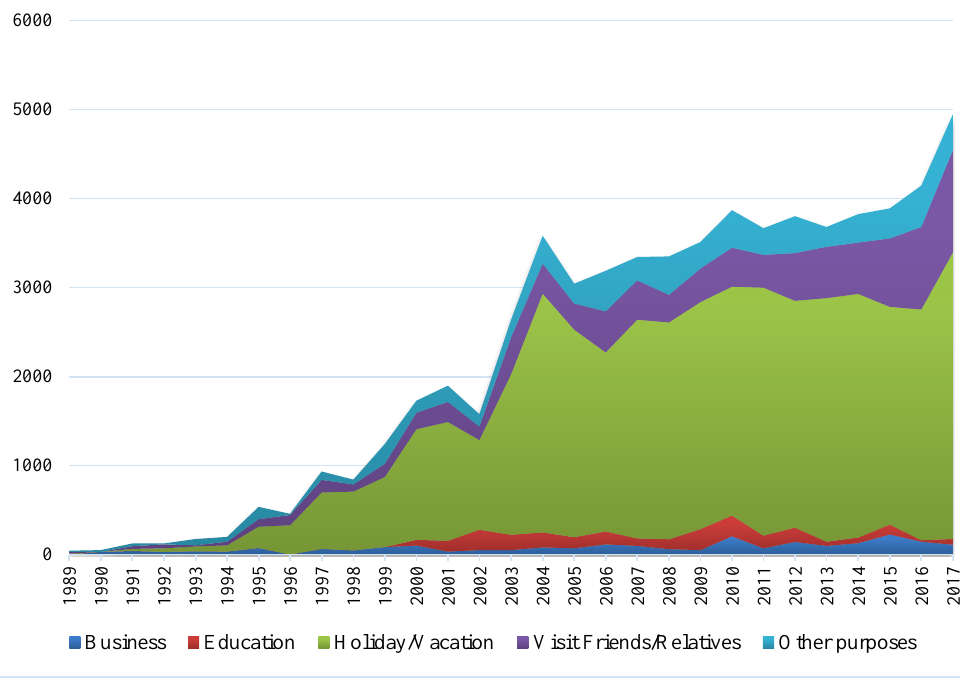
Note: Data for years 1989–1993 refer to Czechoslovakia.